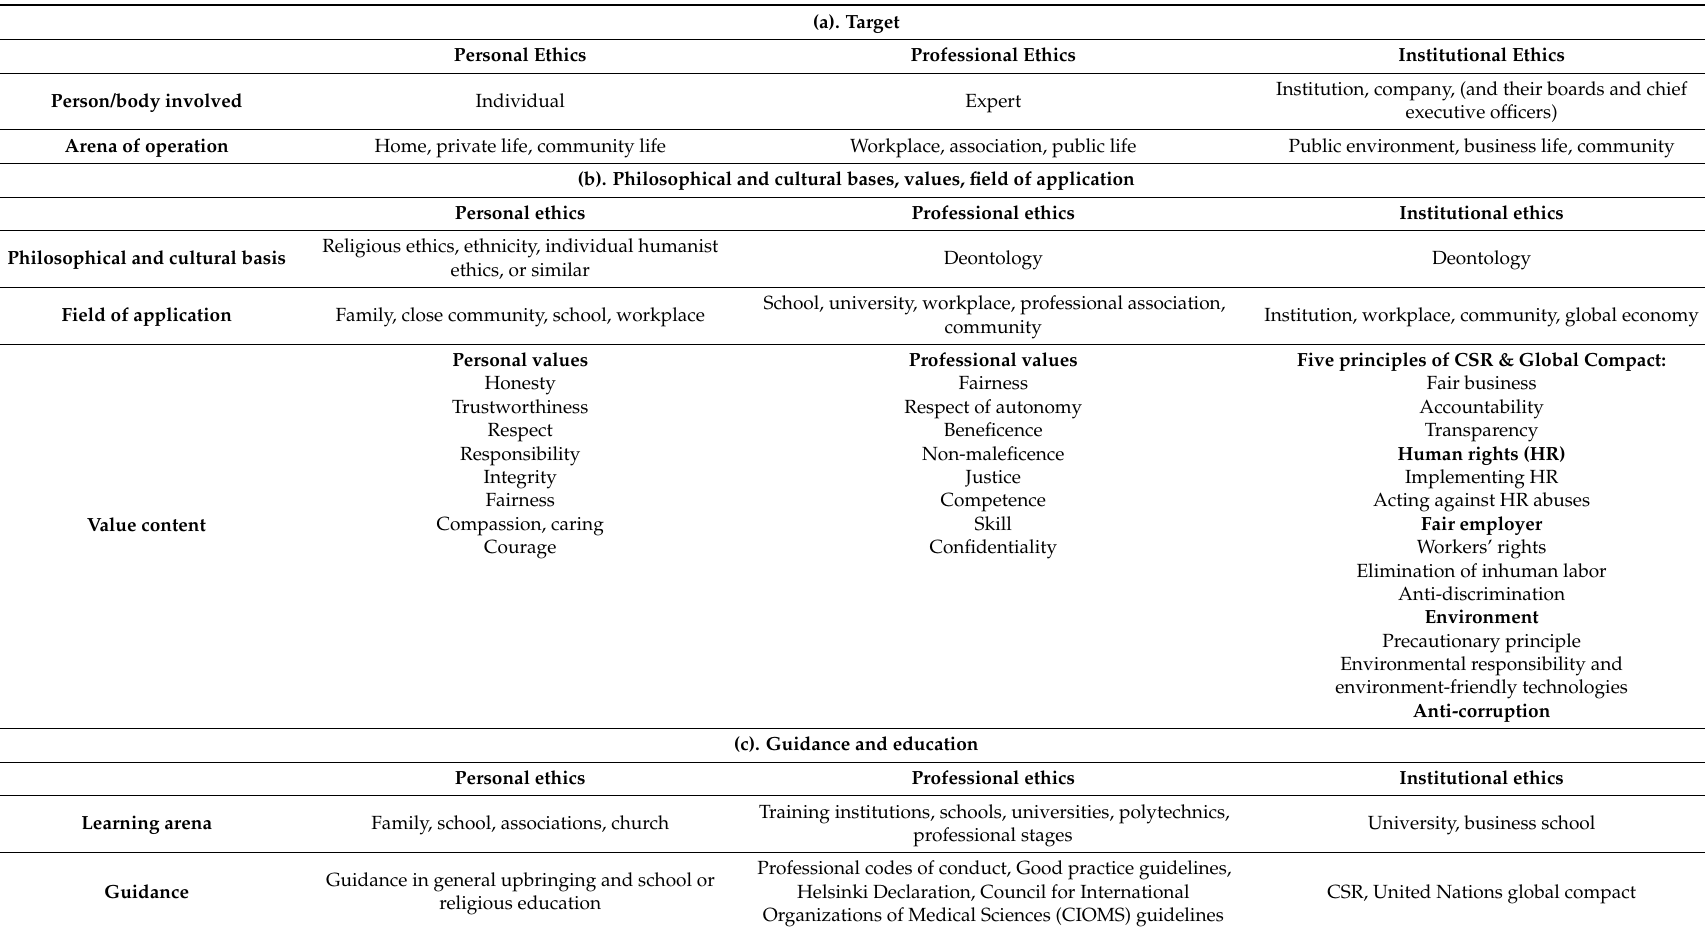
Table 1. Personal, Professional and Institutional